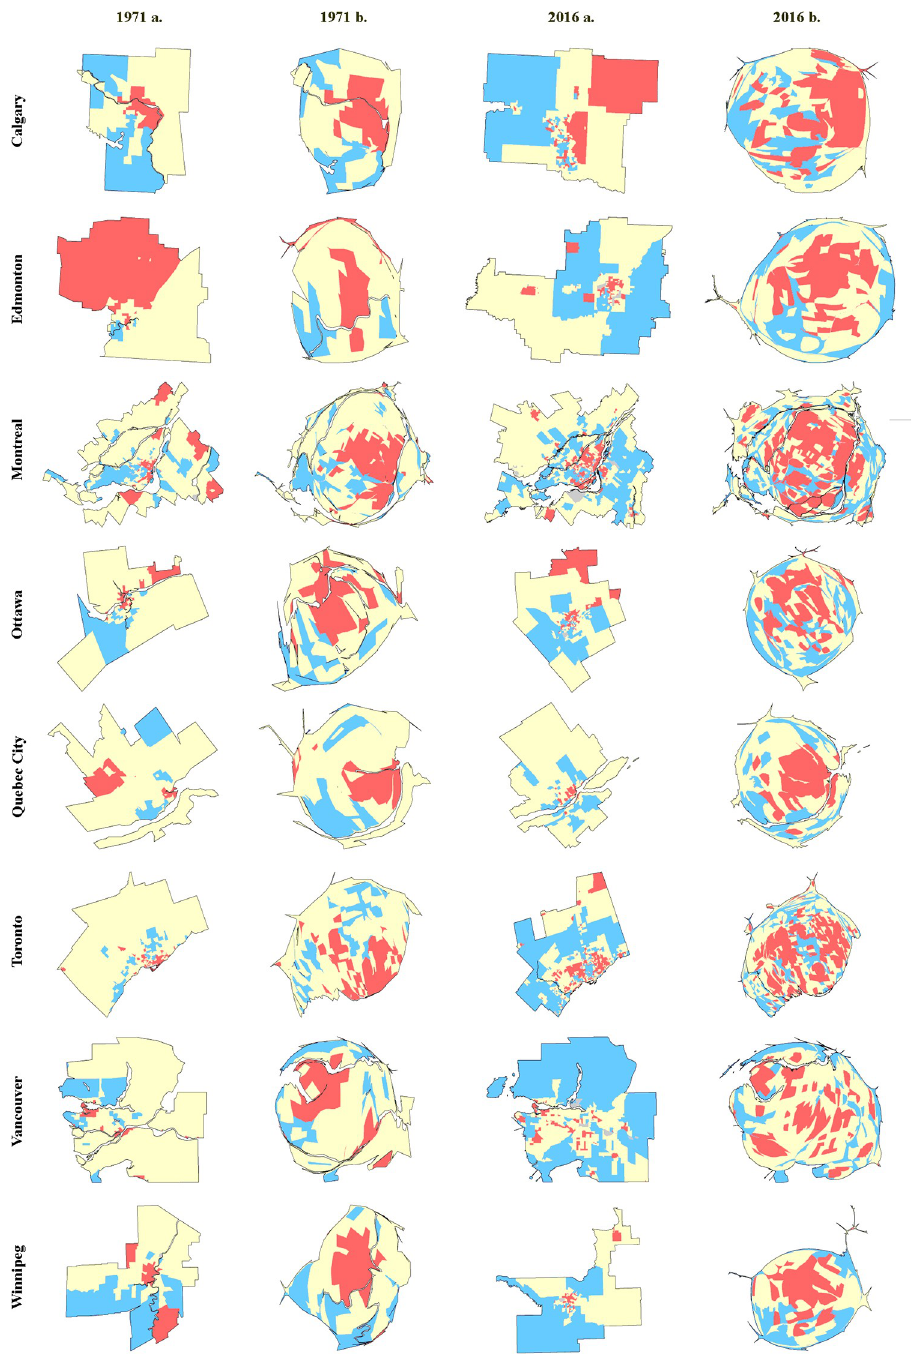
Fig 3. Conventional maps (a) and Cartograms (b) of the temporal evolution of the income structure of Canada’s eight largest CMAs. Low-income CTs (less than 80 percent of average) are in red, middle-income CTs ( ± 20 percent of the average) are in yellow, high-income CTs (above 120 percent of the average) are in blue, and other (no data, or no households) CTs are in grey. Additional maps for each census year for all eight CMAs are provided in the S1